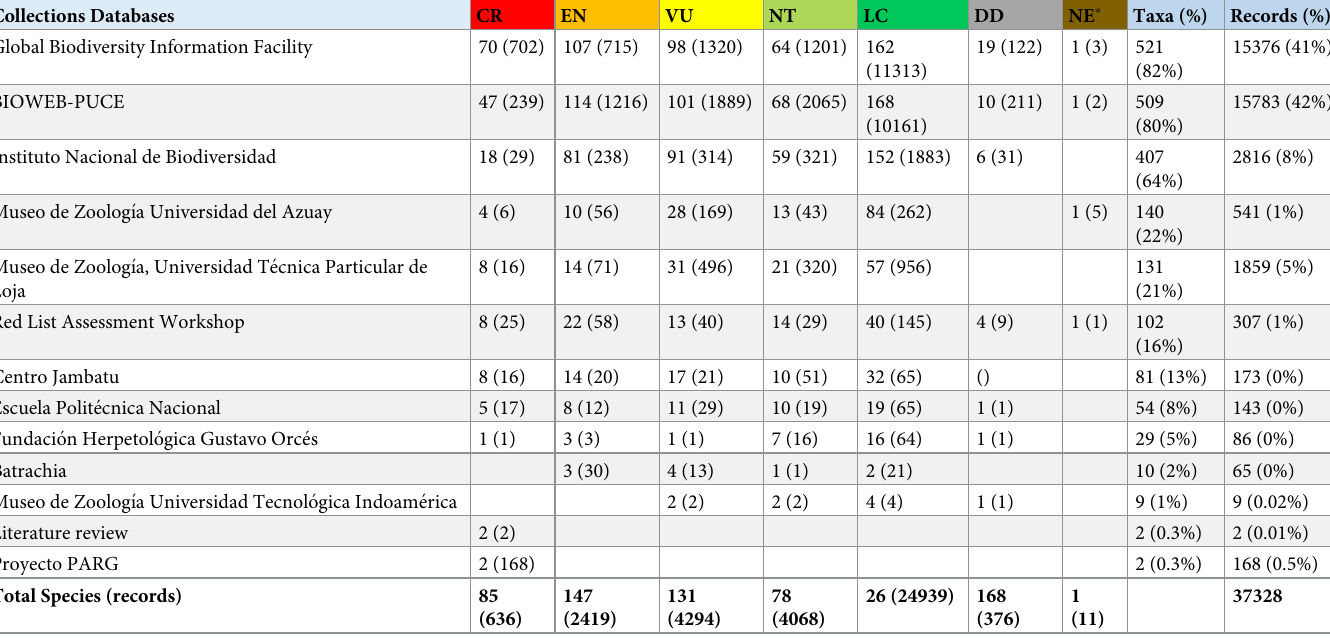
Table 2. Number of taxa and records analyzed from databases for the National Red List Assessment.